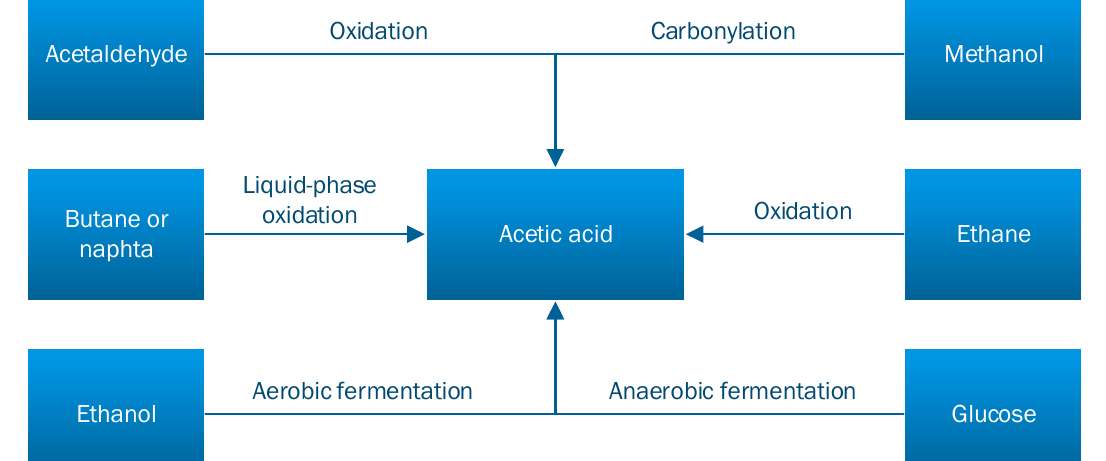
Figure 2. The main methods for obtaining acetic acid [5].